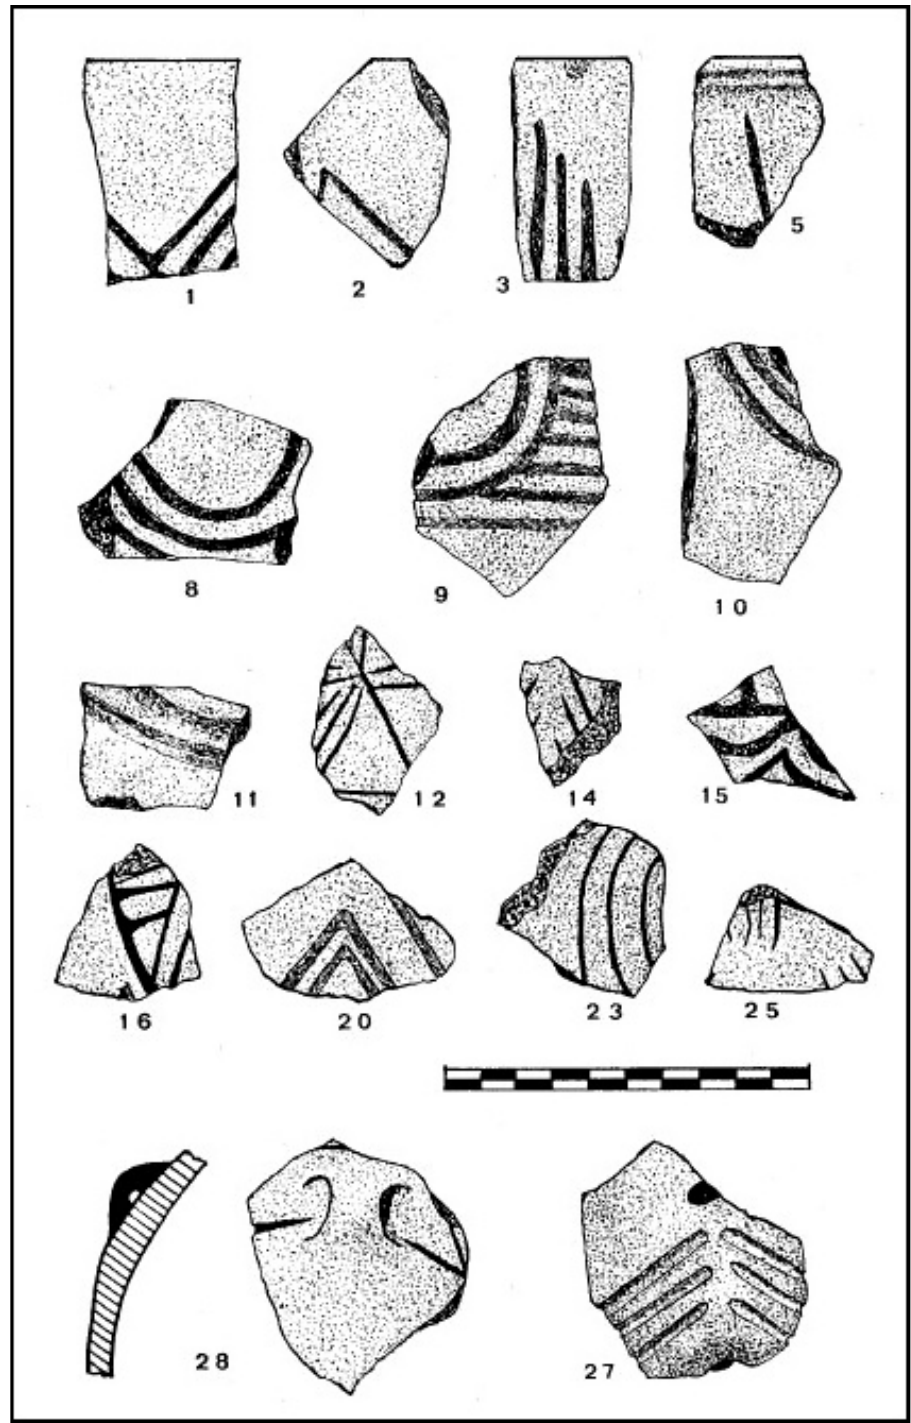
Figure 7. Neolithic ceramic fragments found near the Pirozza hill, at Spalmatore, Ustica (from Mannino, 1998). In the area surrounding the Pirozza hill where clear evidence of a Neolithic presence was discovered, ceramic fragments of subsequent eras, including the Eneolithic, Bronze Age, and Greek and Roman periods, were also found. This evidence suggests that settlement continued in the area following the Neolithic period, developing beyond the area now occupied by the tourist resort (Mannino & Ailara,